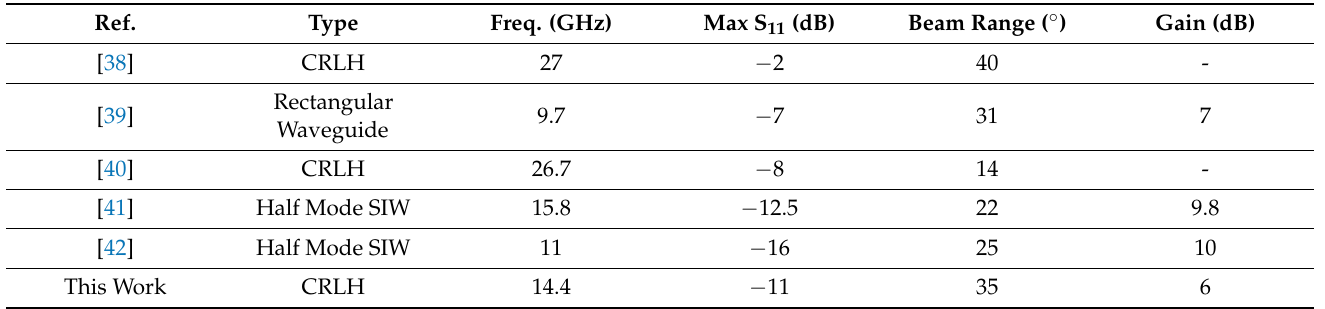
Table 3. Comparison with other LC antennas.